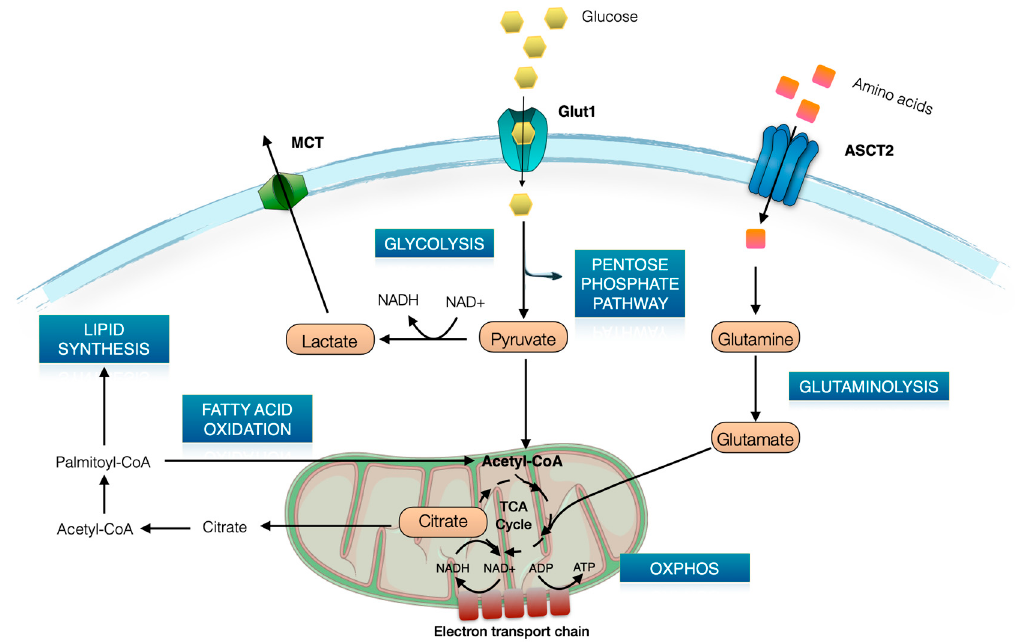
Figure 1. Schematic summary of the metabolic network. ATP can be generated from glucose though two integrated pathways. Glucose enters the cell via Glut1 and undergoes to enzymatic breakdown to pyruvate in the glycolysis pathway in the cytoplasm. The tricarboxylic acid (TCA) cycle encompasses the second pathway, where pyruvate is converted to acetyl-CoA in the mitochondria to fuel oxidative phosphorylation (OXPHOS). Anaerobic glucose catabolism transforms pyruvate into lactate that is transported out of the cell. Other substrates can also be metabolized in the TCA cycle, such as fatty acids via β -oxidation and glutamine via glutaminolysis.